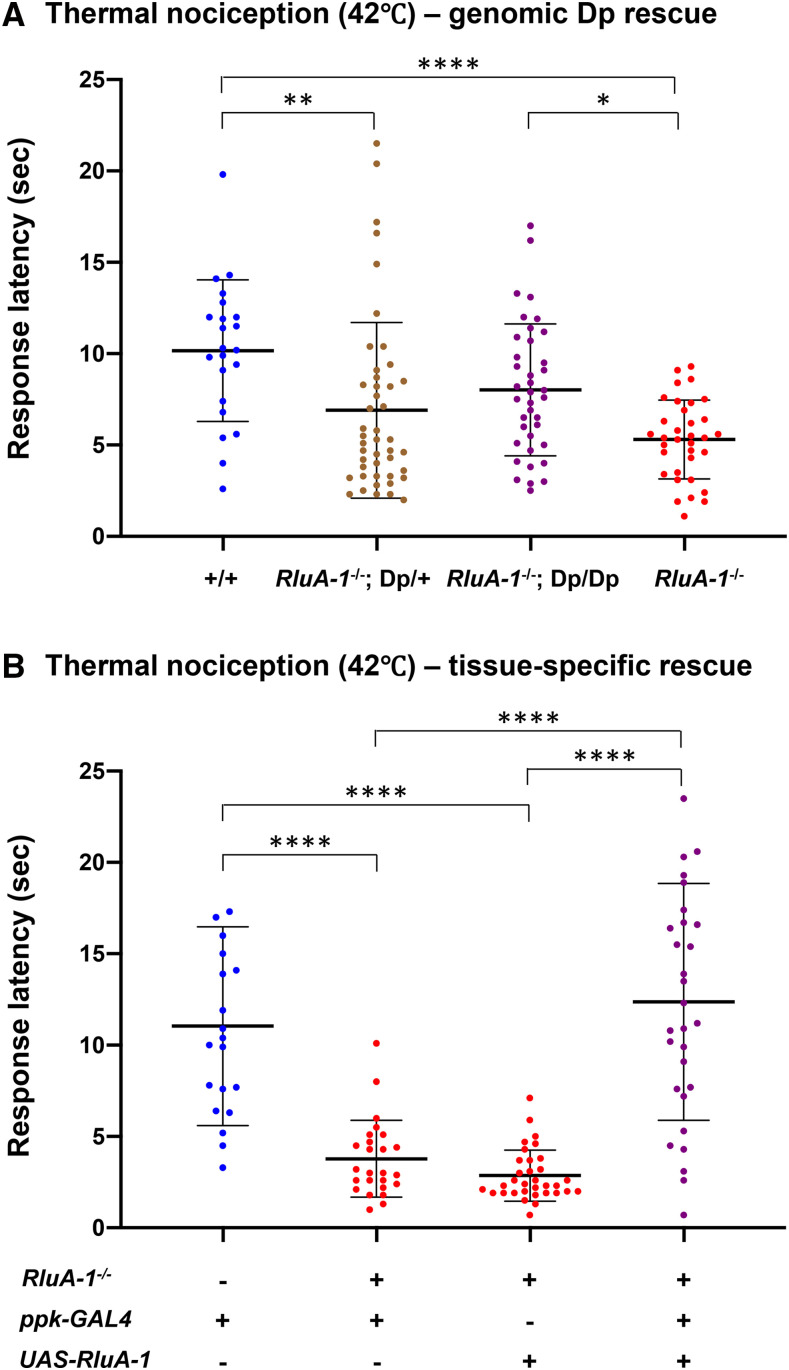
RluA-1 nociception phenotypes with (A) chromosome duplication or (B) Class IV-specific expression of UAS-RluA-1 cDNA. (A). The hypersensitive nociception phenotype with 42° thermal stimulus in RluA-1del-HDR null mutant was rescued by introducing a duplication (Dp) on the third chromosome which covers the RluA-1 gene region (average latency of 8.02 ± 3.61 sec in RluA-1−/−; Dp/Dp, n = 38, which is similar to the isow1118 genetic background (+/+, average latency of 10.16 ± 3.87 sec, n = 22), but significantly slower than the latency of 5.31 ± 2.16 sec in RluA-1−/−, n = 34 (P = 0.02)). Larvae with one copy of duplication showed slower response (average latency of 6.90 ± 4.81 sec in RluA-1−/−; Dp/+, n = 45) without statistical significance compared to RluA-1del-HDR. Data were analyzed using Kruskal-Wallis test with Dunn’s multiple comparison tests. (B). The hypersensitive thermal nociception phenotype in RluA-1del-HDR larvae was completely reversed to that of the heterozygous RluA-1 by Class IV specific expression of full length RluA-1-cDNA (RluA-1−/−; ppk-Gal4+/−; UAS-RluA-1+/−, average latency of 12.37 ±6.48 sec, n = 30, is similar to RluA-1+/−; ppk1.9-Gal4+/−, average latency of 11.04 ± 5.44 sec, n = 20 but significantly slower than either the driver alone (RluA-1−/−; Ppk1.9-Gal4+/−, average latency of 3.78 ± 2.11 sec, n = 25 or transgene alone controls (RluA-1−/−; UAS-RluA-1+/−, average latency of 2.86 ± 1.39 sec, n = 33) at 42°C thermal stimulus. Significance of the comparisons are marked as **** (P < 0.0001). Data were analyzed using Kruskal-Wallis test with Dunn’s multiple comparison tests. Error bars in all the figures represent S.D.